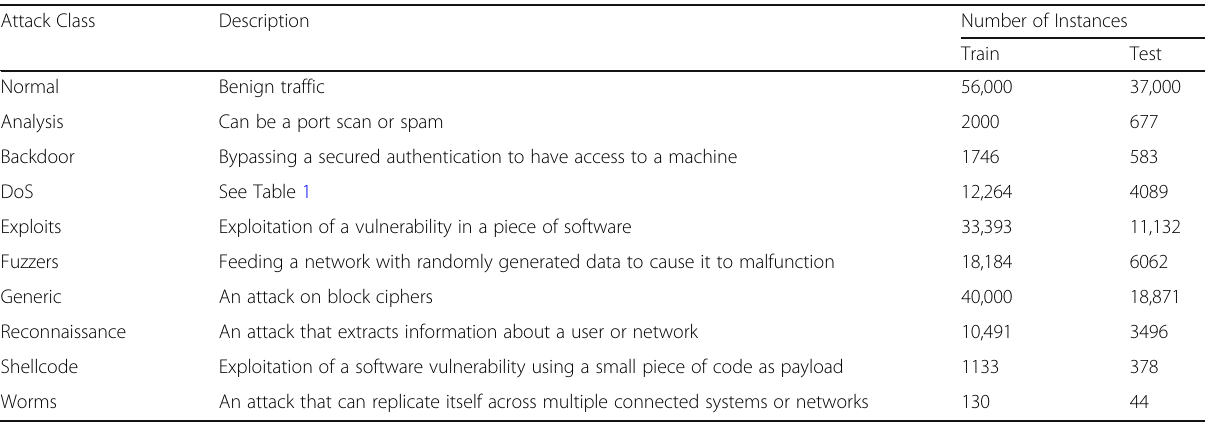
Table 2 Evolving Attacks in the UNSW_NB15